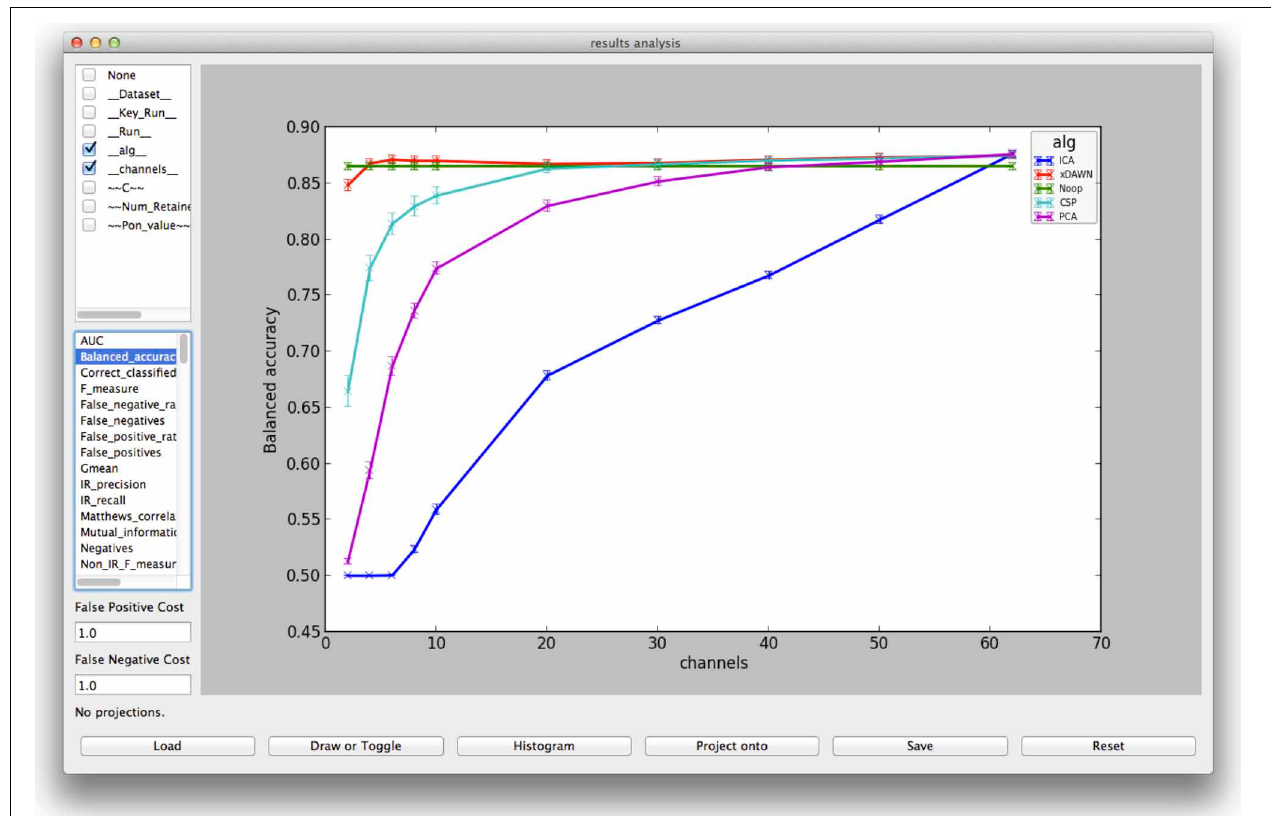
FIGURE 6 | Visualization from the evaluation GUI for the result of the spatial filter comparison, explained in section